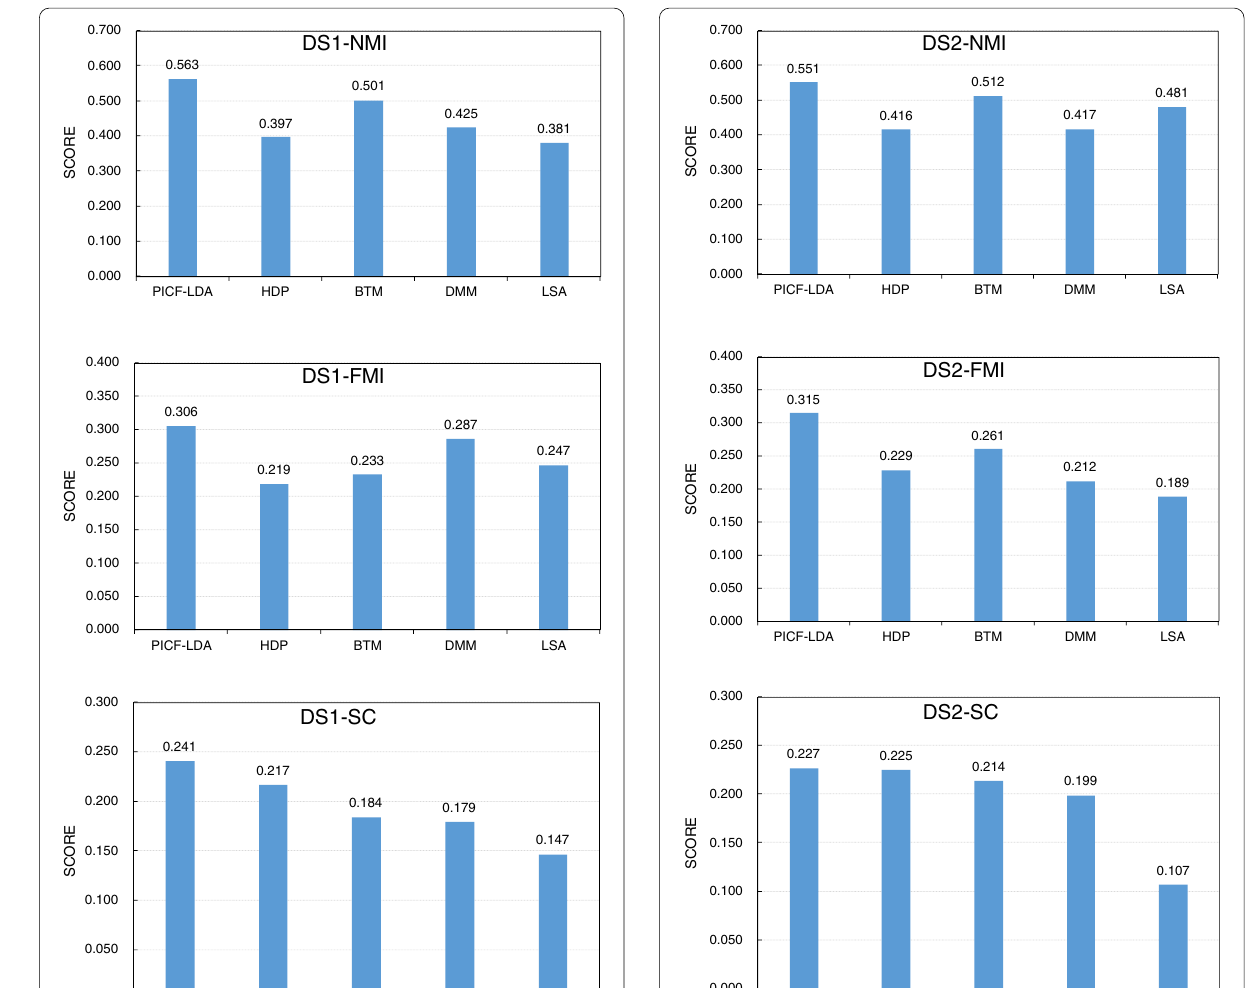
Result and comparison